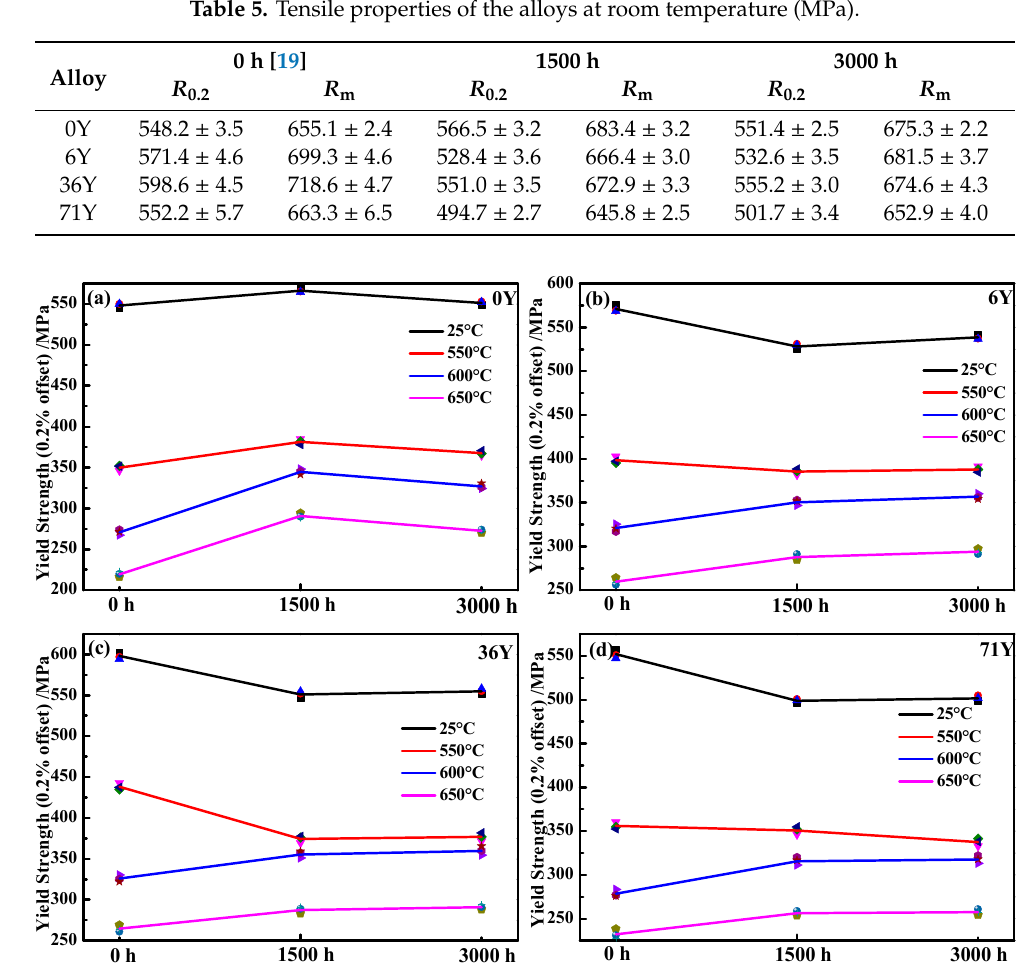
Figure 6. Tensile properties of the steels vs. temperature: ( a ) 0Y, ( b ) 6Y, ( c ) 36Y, ( d ) 71Y. Table 5. Tensile properties of the alloys at room temperature (MPa).